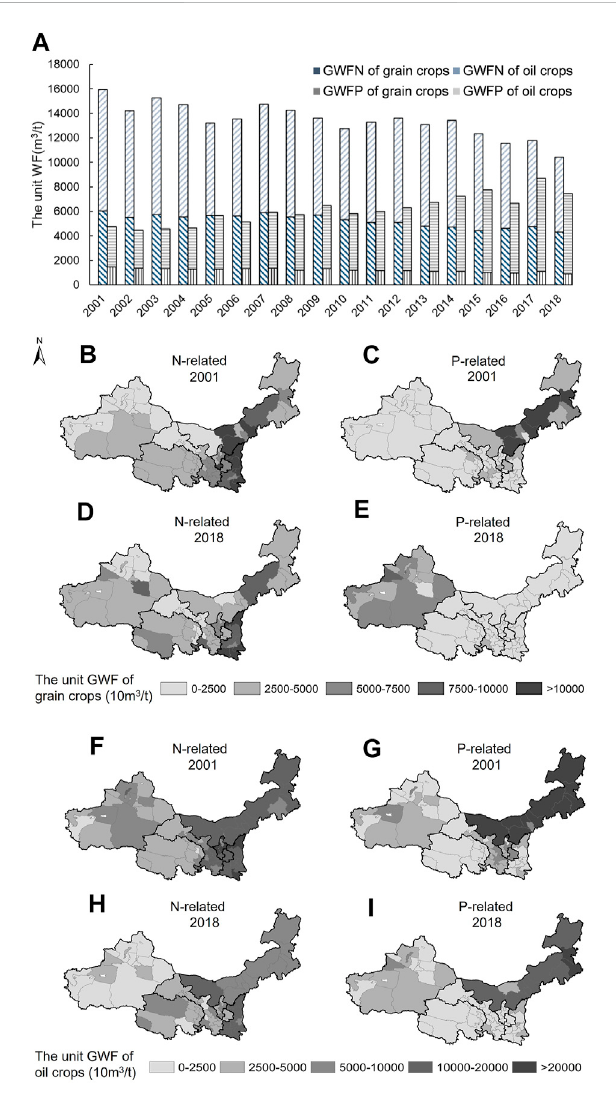
FIGURE 3 Spatiotemporal evolution of N- and P-related unit GWF in West China. (A) Theinterannualvariation intheunitGWFofgraincropsand oil cropsfrom2001to2018; (B – E) thespatialdistributionoftheunitGWFof grain crops in 2001 and 2018; (F – I) the spatial distribution of the unit GWF of oil crops in 2001 and